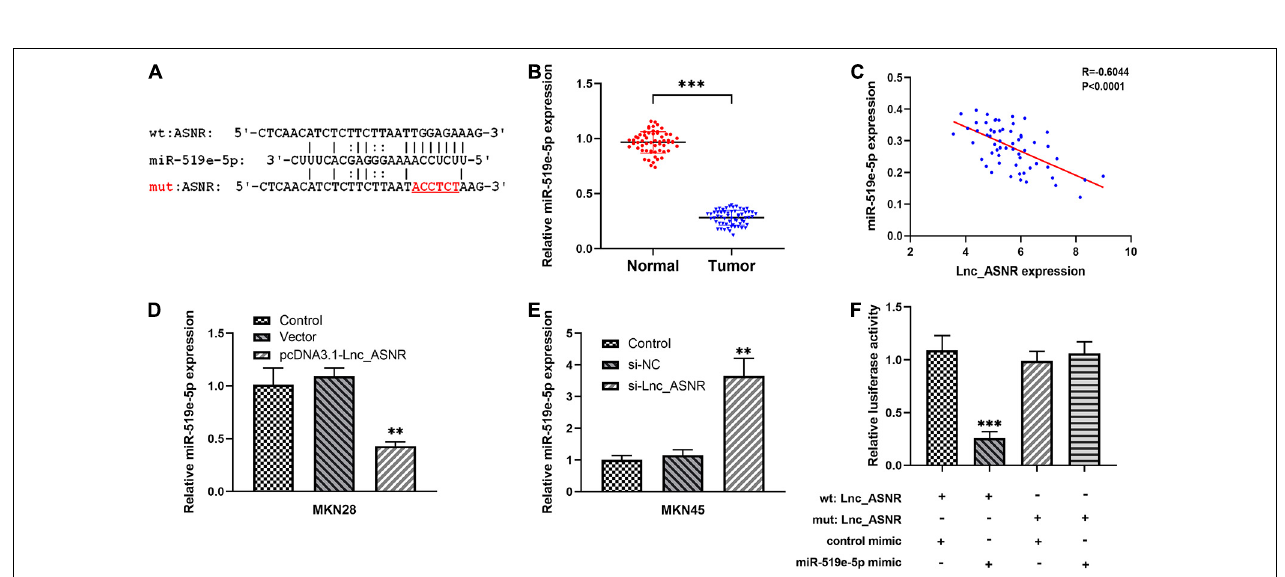
FIGURE 5 | The relationship between Lnc_ASNR and miR-519e-5p. (A) The predicted combining positions between Lnc_ASNR and miR-519e-5p were predicted by using “miRDB” website (http://mirdb.org/). (B) qRT-PCR was applied to indicate the expression of miR-519e-5p in GC tissue samples and adjacent non-tumor tissue samples. (C) Correlation analysis was used to evaluate the relationship between miR-519e-5p expression and Lnc_ASNR expression. (D) qPCR detected the levels of miR-519e-5p in GC cells after Lnc_ASNR was overexpressed. (E) qPCR detected the levels of miR-519e-5p in GC cells after Lnc_ASNR was silenced. (F) Luciferase activity detection. Error bars, mean ± SEM. * P < 0.05; ** P < 0.01; *** P < 0.001.